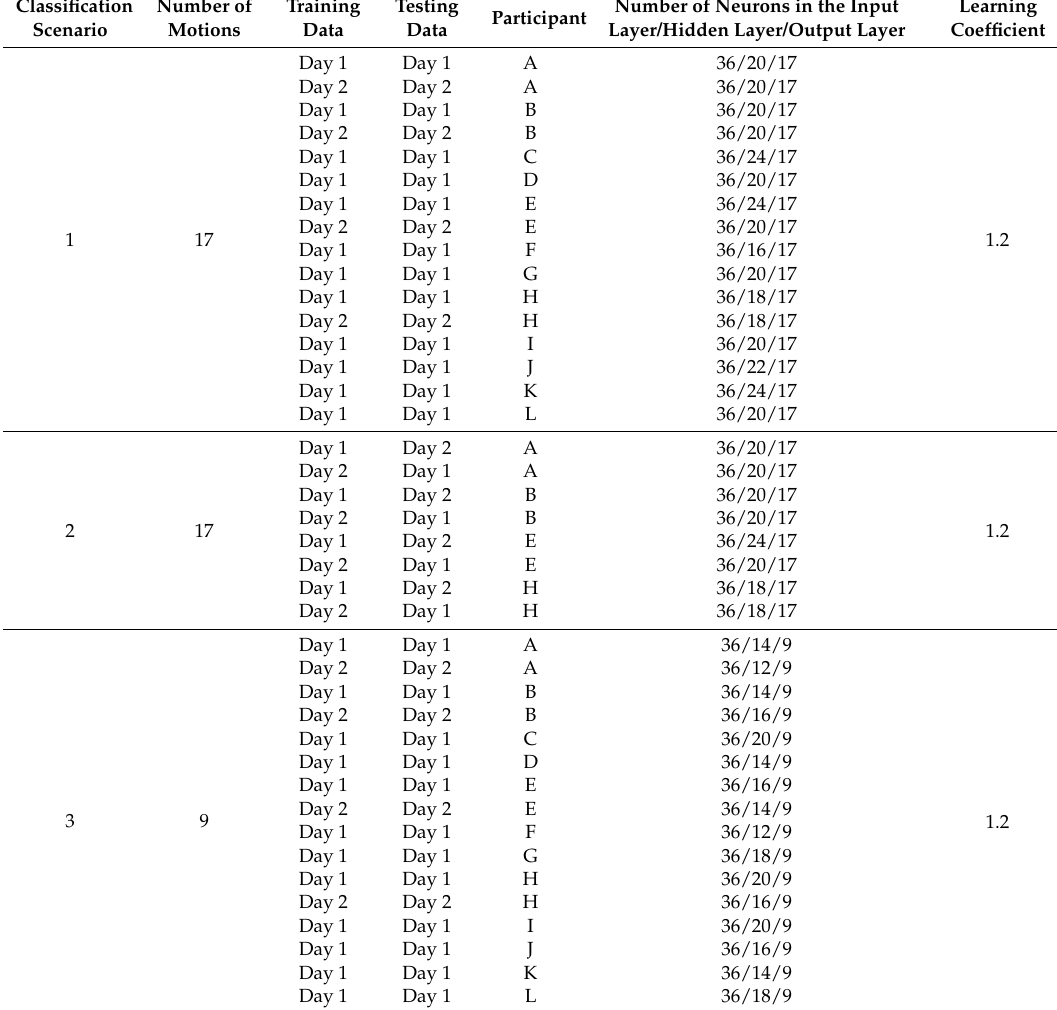
Table 2. Details of each classification